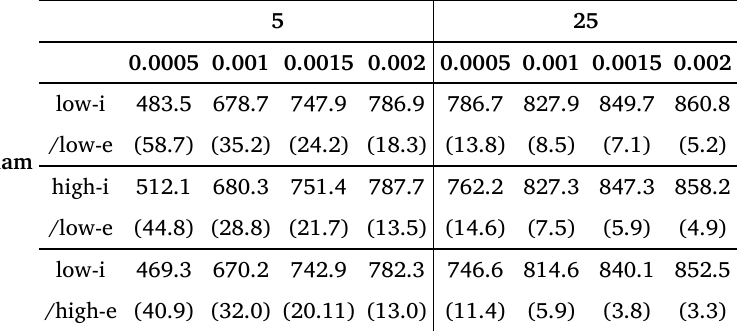
Table 8: Summary of mean of summed accuracy of the model runs optimized with Adam with combinations of hidden and embedding dimensions (5, 25) and learning rates (0.0005, 0.001, 0.0015, 0.002). Standard deviations are presented in brackets